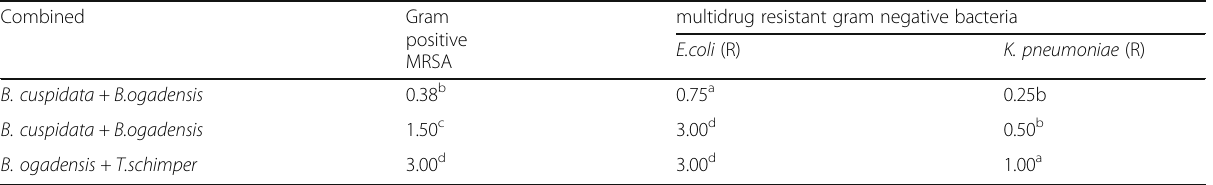
Table 5 The mean fractional inhibitory concentration index for MDR bacteria at AAU, 2018